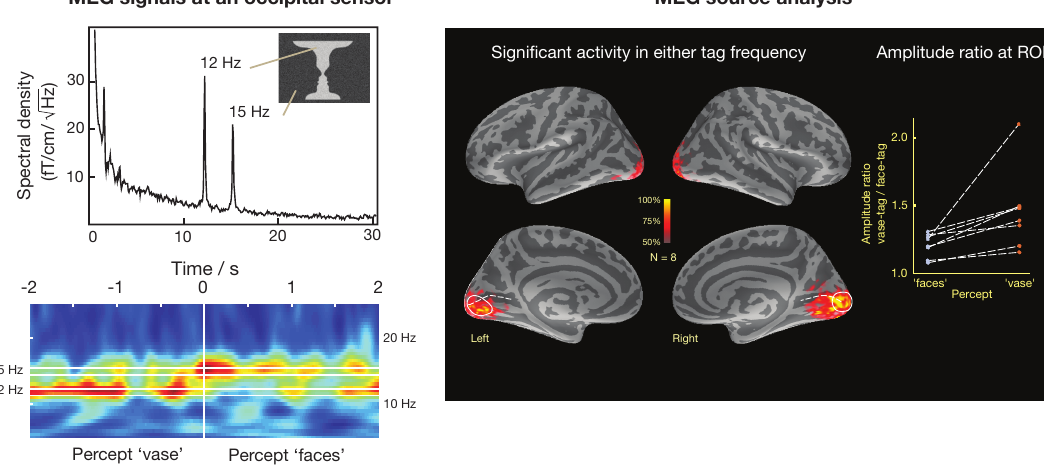
Figure 9. Distributed source estimates without functional magnetic resonance imaging (fMRI) constraints in the visual system. (Left) An indication of a percept is seen in early visual areas with help of frequency-tagged stimuli. Top plot shows a power spectrum with two clear peaks at each tagging frequency. Bottom plot depicts a time-frequency analysis with the white vertical line corresponding to the time at which there is a perceptual change. There is a clear shift in peak frequency of activity from one tagging frequency to the other (12 Hz–15 Hz) at this point in time. (Right) Change in the relative strength of activity in an occipital MEG sensor when the percept changes. Location and strength of activity is depicted on inflated lateral and medial brain surfaces in the left panel. White broken lines identify the calcarine sulcus, whereas white sold lines denote a region of interest. The right panel depicts amplitude ratios for stimuli at each tagging frequency. For details, see the